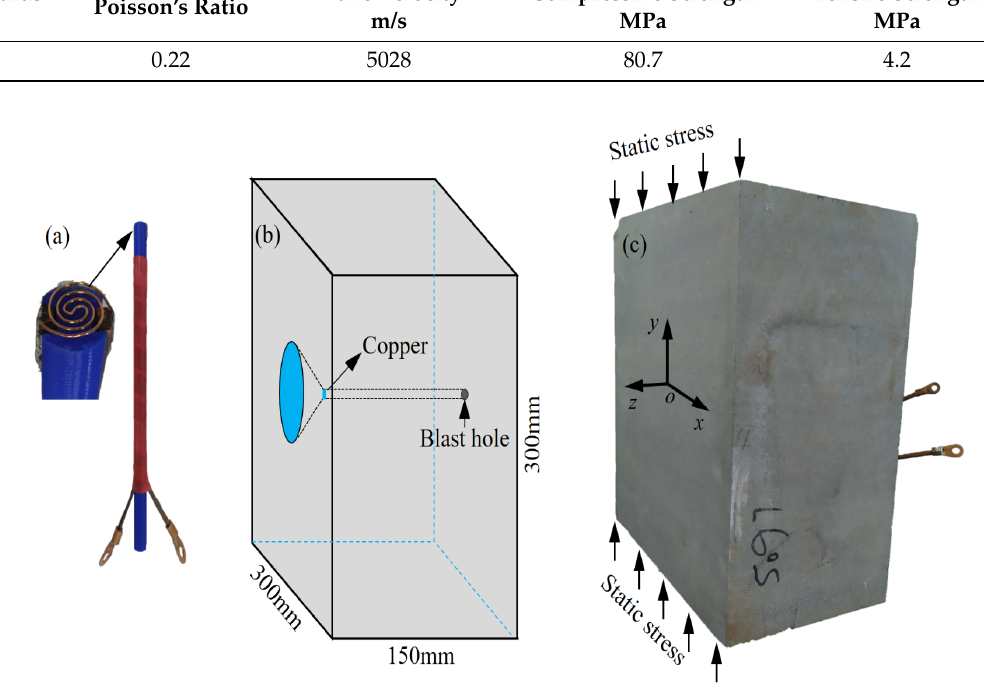
Figure 2. Schematic diagram and photo of specimen. ( a ) Electrode; ( b ) schematic diagram; ( c )